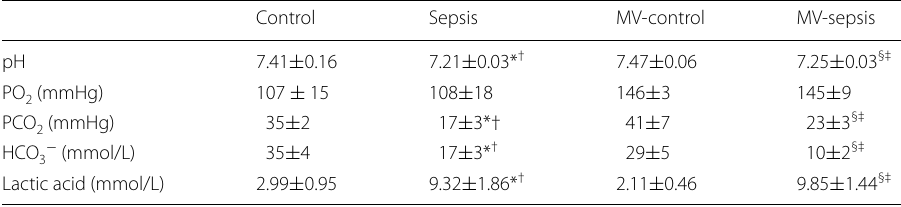
Data are means SEM from 6 animals per group. Data are means ± control; † p < 0.05 sepsis versus MV-control; ‡ p < 0.05 MV-sepsis versus control and § p < 0.05 MV-sepsis versus